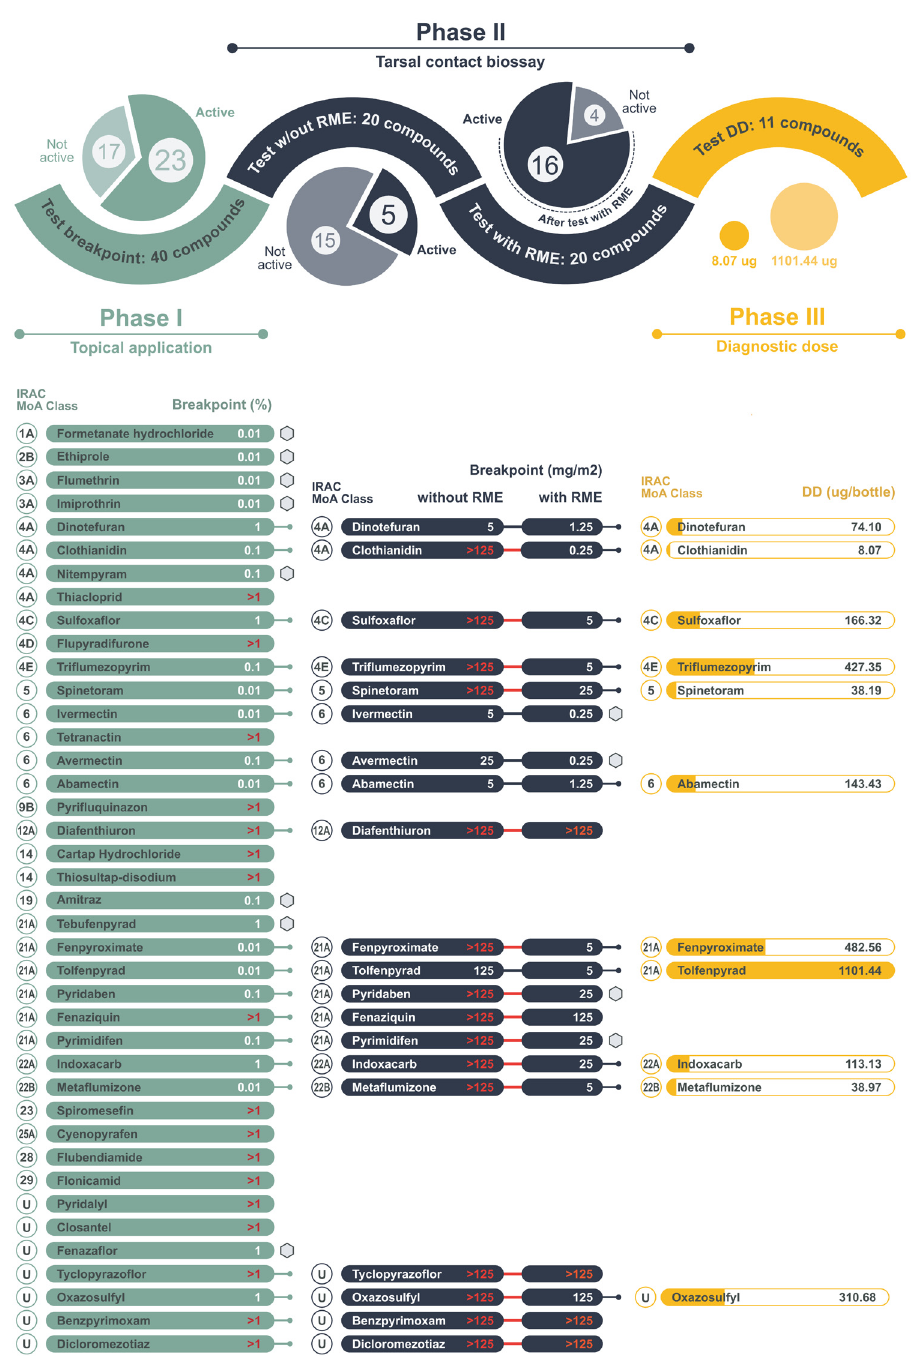
Figure 1. Testing cascade to screen existing insecticides for use against mosquito disease vectors, including key findings. Intrinsic insecticidal activity is measured by topical application of compound directly onto adult female Anopheles gambiae mosquitoes, activity through tarsal contact is measured in a bioassay with and without RME as an adjuvant, and relative potency is judged by determining the discriminating dose in CDC bottle bioassays. Activity in Phase I was defined as ≥ 80% mortality 24 hours after topical application, and the breakpoint denotes the concentration at which activity was first observed; ‘>1’ means that activity was not observed even when the highest concentration, 1% active ingredient, was applied. Activity in Phase II was defined as ≥ 80% mortality 24 hours after tarsal exposure, and the breakpoint denotes the concentration ay which activity was first observed; ‘>125’ means that activity was not observed even at the highest concentration tested, 125 mg/m 2 . Compounds which were only active in tarsal contact bioassays (Phase II) in the presence and not the absence of RME are highlighted in red. Of 40 compounds from 20 IRAC MoA classes, and 7 compounds not listed or not classified by IRAC, 11 compounds are shortlisted for further investigation. The hexagon symbol denotes compounds which showed insecticidal activity during screening but which were not progressed for other